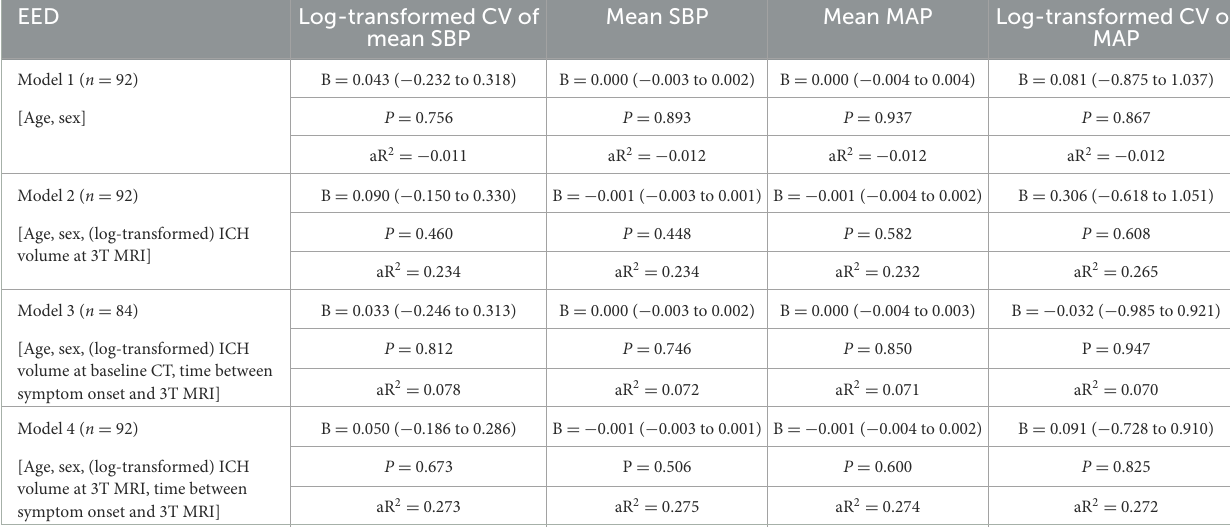
TABLE 3 Multivariable regression analyses for the influence of different BP measurements in the first week on the EED on 3T MRI. EED Log-transformed CV of Mean SBP Mean MAP Log-transformed CV of mean SBP